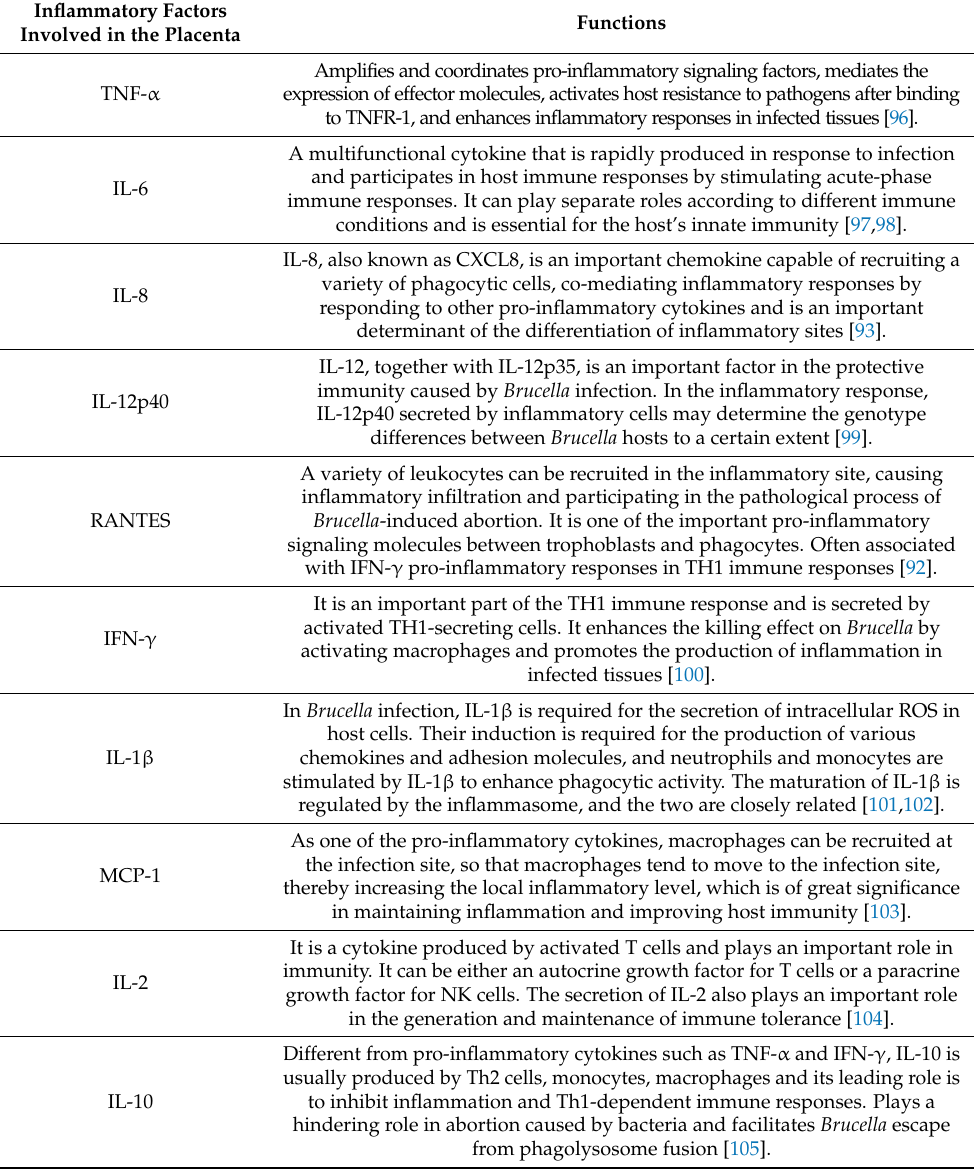
Table 1. Related cytokines involved in the infection of trophoblast cells by Brucella